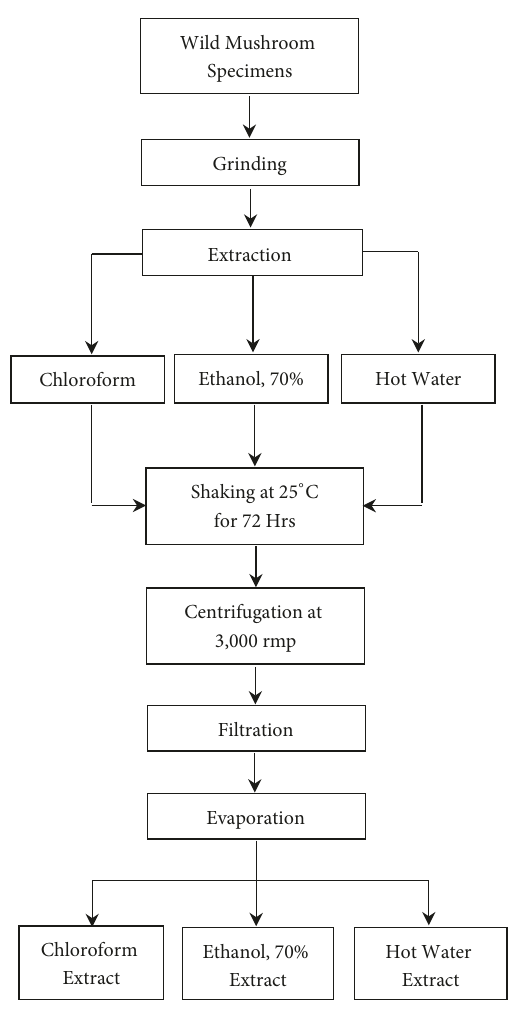
Figure 2: Extraction process of mushroom